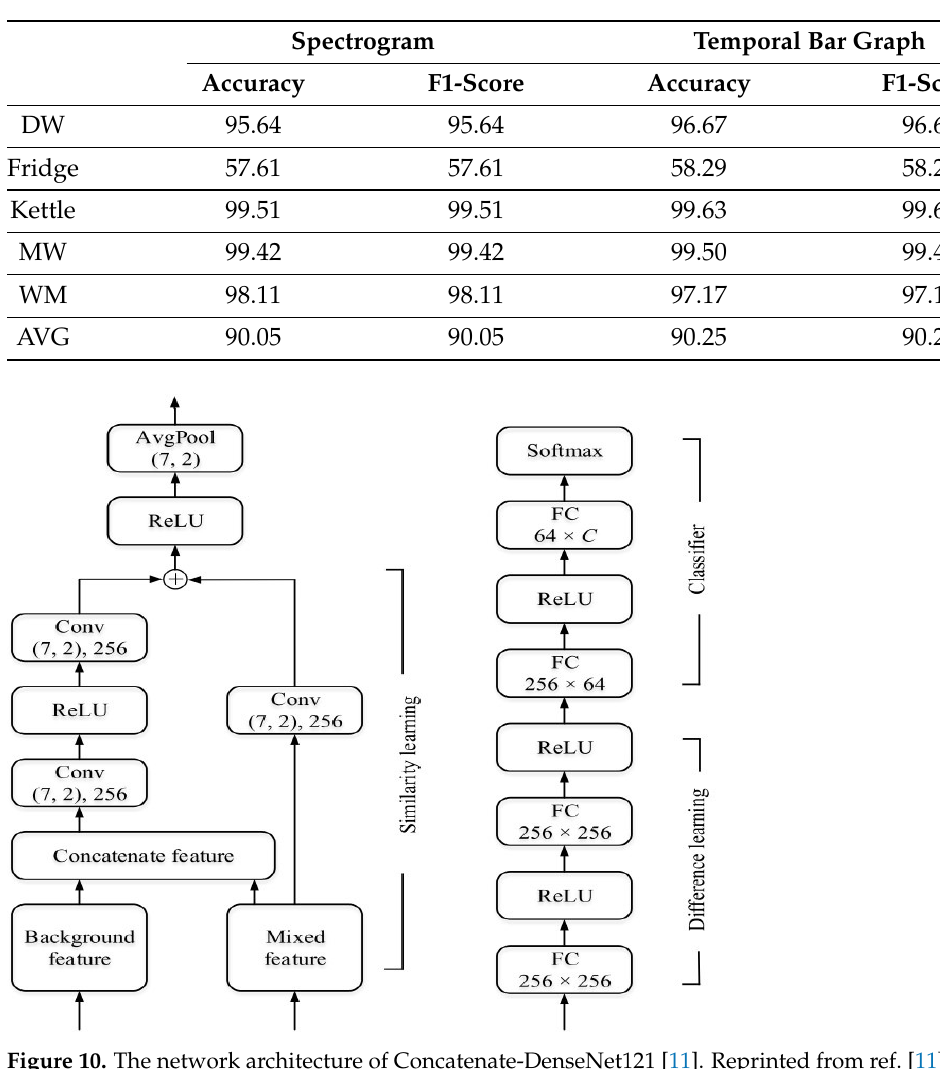
Table 13. The results with Concatenate-DenseNet121.